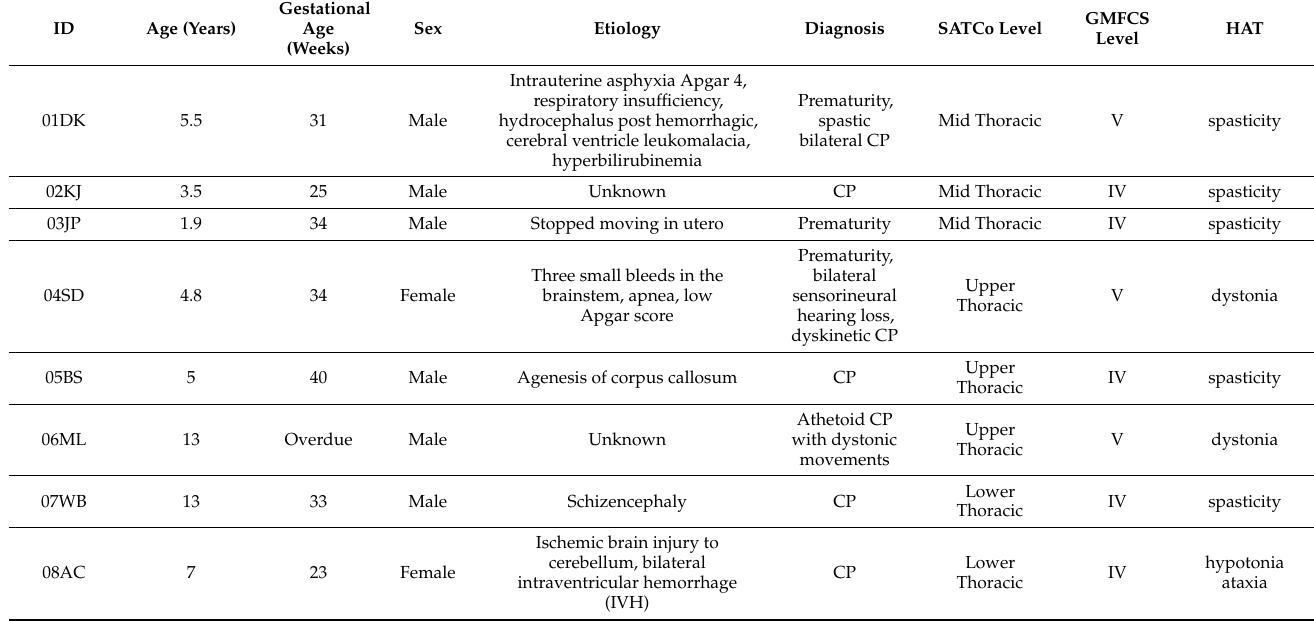
Table 1. Subject Demographics. Etiologies, diagnoses, differential diagnoses and GMFCS (Gross Motor Function Classification System) levels as provided by the families’ previous participation in the Pediatric Balance Lab. Segmental Assessment of Trunk Control (SATCo) levels were determined at the start of each session. Muscle tone was confirmed for each child using the Hypertonia Assessment Tool (HAT) [48]. One child (08AC) did not demonstrate hypertonia. She had a medical diagnosis that included hypotonia and